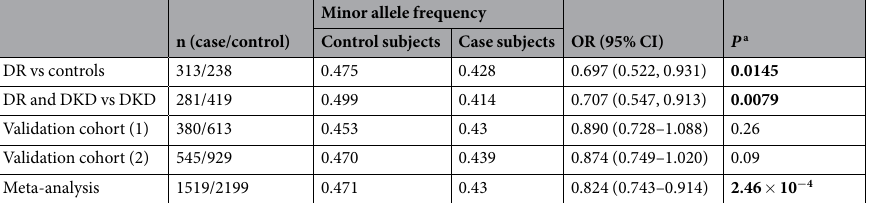
Table 2. Association of CDKAL1 rs7756992 with DR in Chinese patients with type 2 diabetes. DKD = diabetic kidney disease; DR = diabetic retinopathy. P values < 0.05 are shown in bold. a Adjusted for duration of diabetes, HbA 1c , systolic blood pressure, diastolic blood pressure, body mass index. The OR with 95% CI shown is for the minor allele.